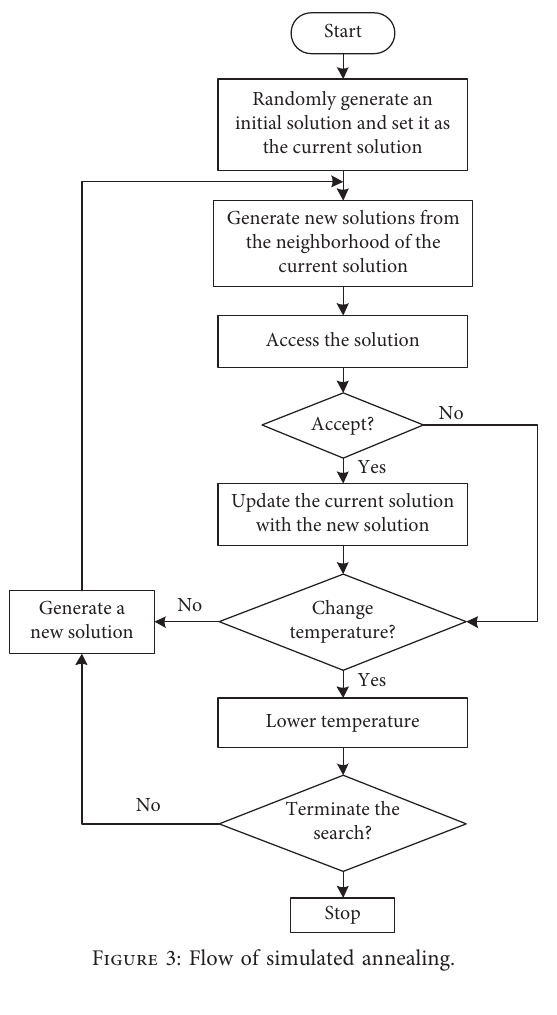
Figure 3: Flow of simulated annealing.